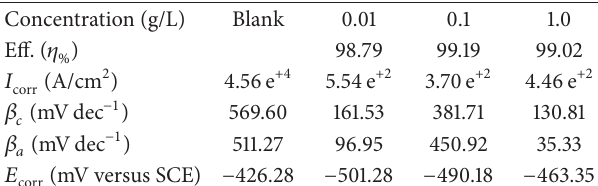
Figure 4: Potentiodynamic polarization curve for pipeline steel in 0.5 M sulfuric acid with different concentrations of Brassica oleracea extract at 333 K. Table 4: Potentiodynamic polarization parameters for pipeline SO with and without different concentrations of steel in 0.5 M H 2 4 Brassica oleracea extract at 323 K.